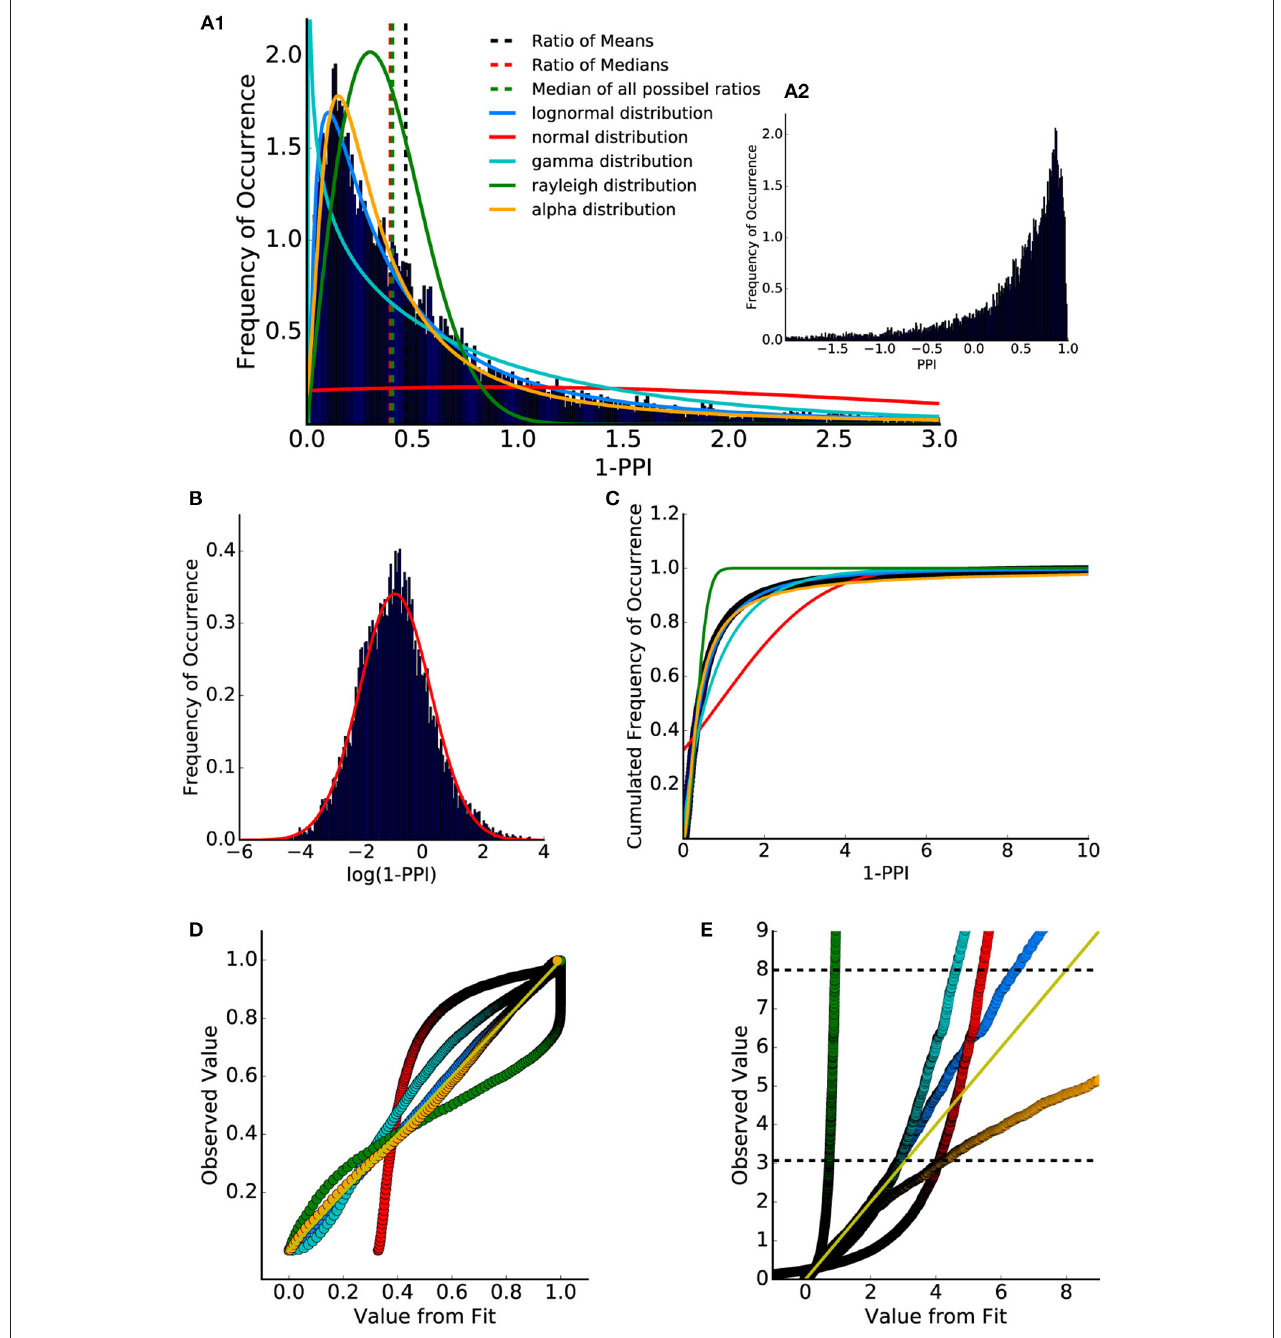
FIGURE 2 | Distribution of ASR amplitude ratios and PPI values. (A1) Ratio between all combinations of gap and no-gap ASR amplitudes (1-PPI). Data were fitted with lognormal (solid blue), gamma (solid cyan), Rayleigh (solid green), and alpha (solid orange) distribution (normed probability densities). Ratio of means of gap and no-gap ASR amplitudes (dashed black) differed from the ratio of medians of gap and no-gap ASR amplitudes (dashed red), which is similar to the median of the (full combinatorial) ratio distribution (dashed green). (A2) Distribution of PPI values (1-A_gap/A_no-gap). The histogram shows that the PPI values cover a wide codomain including a considerable number of negative values (] −∞ ,1]). (B) Histogram of the logarithmized (base e) ASR amplitude ratios. When plotted this way, the data are almost Gaussian-like distributed. (C) Cumulative distribution of the ASR amplitude ratios (dark blue dots) and cumulative distribution function of the fitted distributions: lognormal (blue) and Gaussian (red), gamma (cyan), Rayleigh (green) and alpha (orange). (D) p-p plot shows that the lognormal distribution describes the data best. However, the q-q plot (E) provides evidence that for percentiles higher than 95% (lower black dashed line) the lognormal distribution slightly differs from the measured